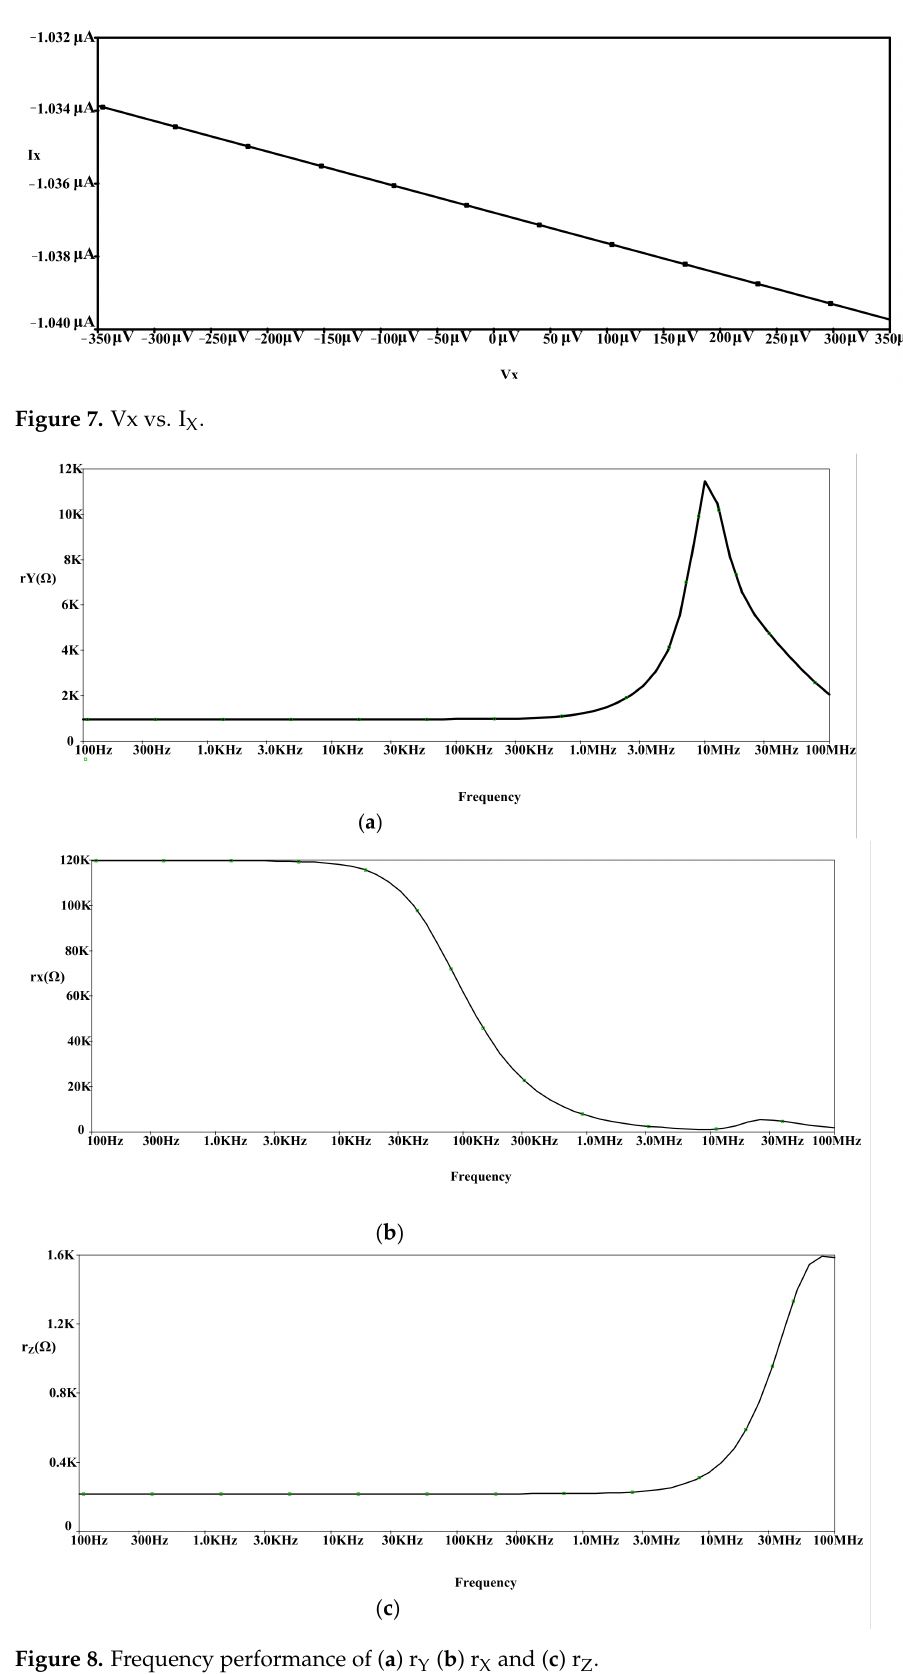
Figure 8. Frequency performance of ( a ) r Y ( b ) r X and ( c ) r Z